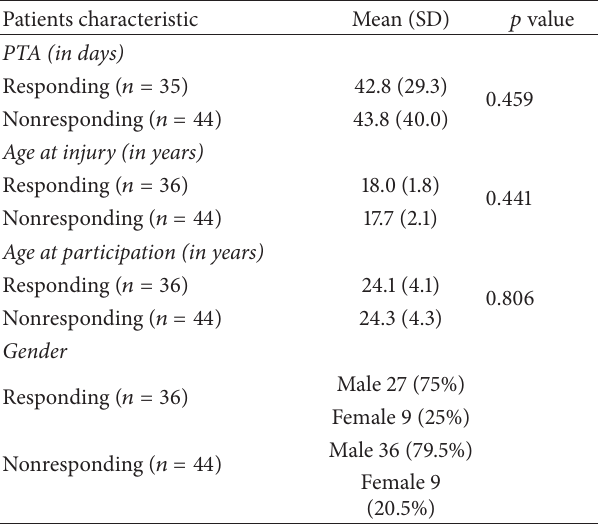
Table 5: Comparison between responder and nonresponders (con- tacted sample 𝑛 = 80